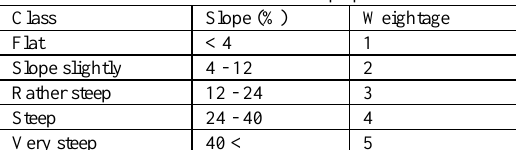
TABLE 3. Classification of slope perameter.